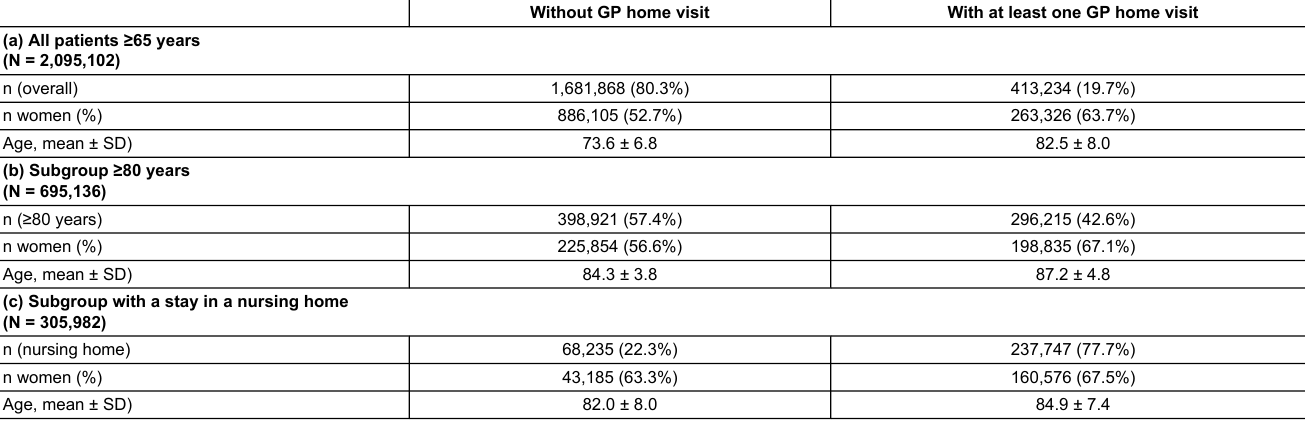
Table 1: Descriptive statistics of the extrapolated population for patients without vs with at least one GP home visit during the entire observation period (2014–2018), for the en- tire population (≥65 years) as well as for the two subgroups including patients ≥80years and patients living in a nursing home. Without GP home visit With at least one GP home visit